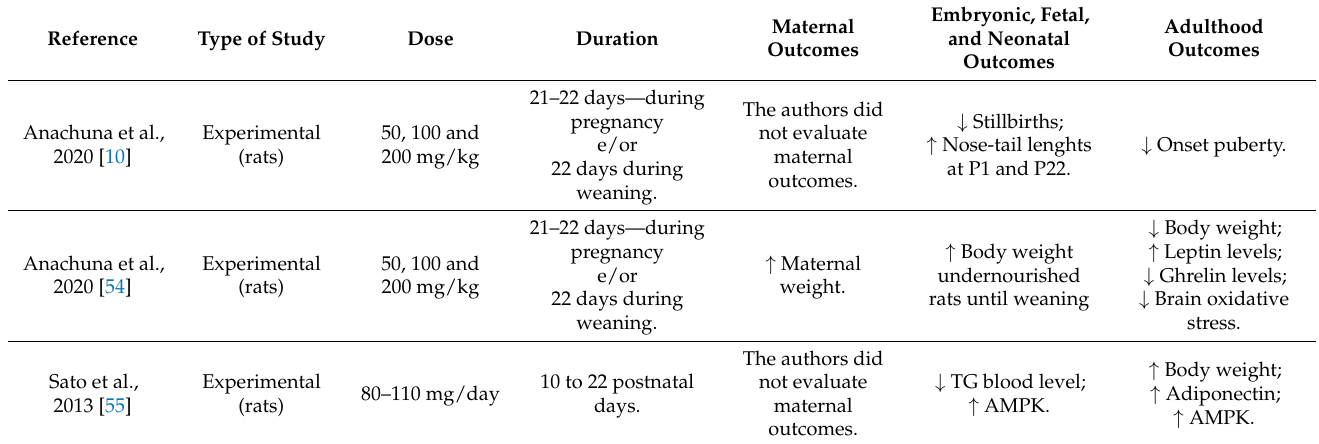
Table 2. Studies using quercetin in the treatment of perinatal undernutrition. The up arrow ↑ represents increase, down arrow ↓ represents